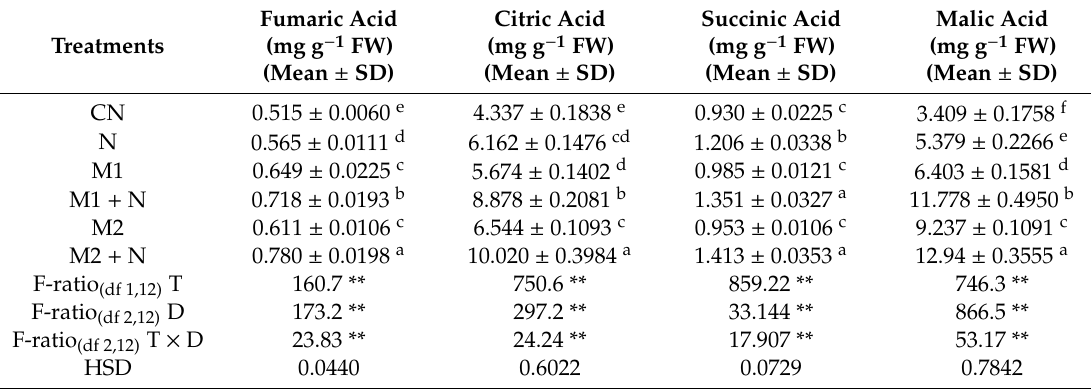
Data is presented as means of three replicates ± SD and HSD values. F ratio values, * indicates significance at p ≤ 0.05 and ** indicates significance at p ≤ 0.01). Di ff erent letters on the table indicate that mean values of treatments are significantly di ff erent at p < 0.5 according to Tukey’s multiple comparison